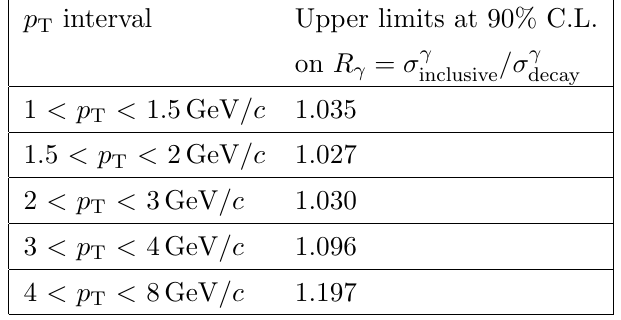
Table 6 . Upper limits at 90% C.L. on the ratio of inclusive to decay photon cross